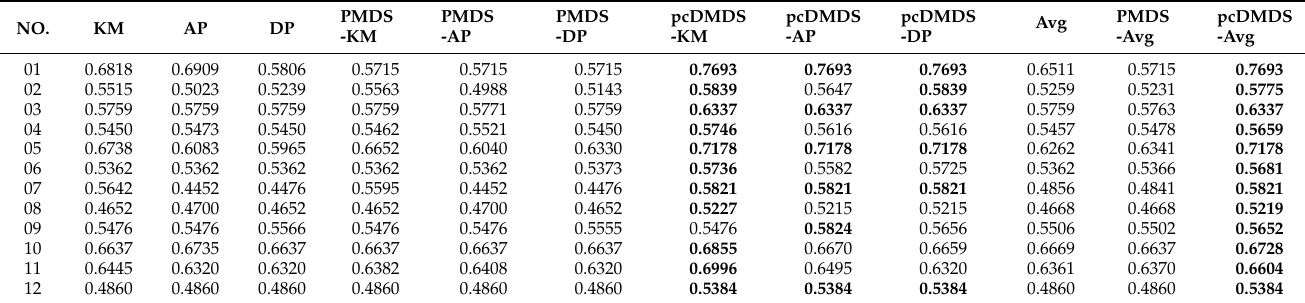
Table 3. Purity of clustering with different data